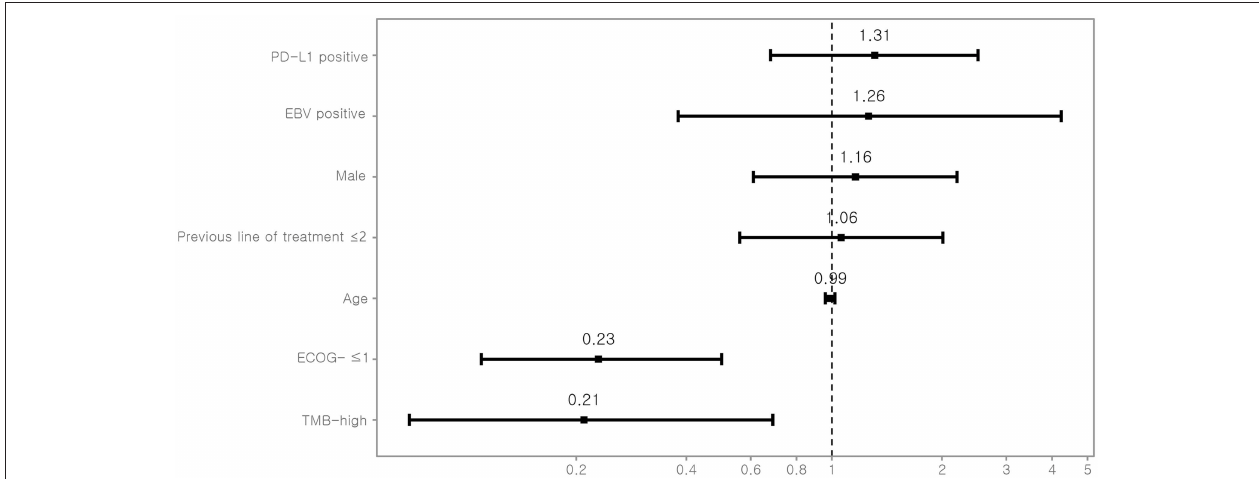
FIGURE 4 | Multivariate Cox-regression analysis for PFS. For each variable, the estimated hazard ratio with 95% confidence interval is shown. PD-L1, programmed death-ligand 1; EBV, Epstein-Barr virus; ECOG, Eastern Cooperative Oncology Group performance status; TMB, tumor mutational